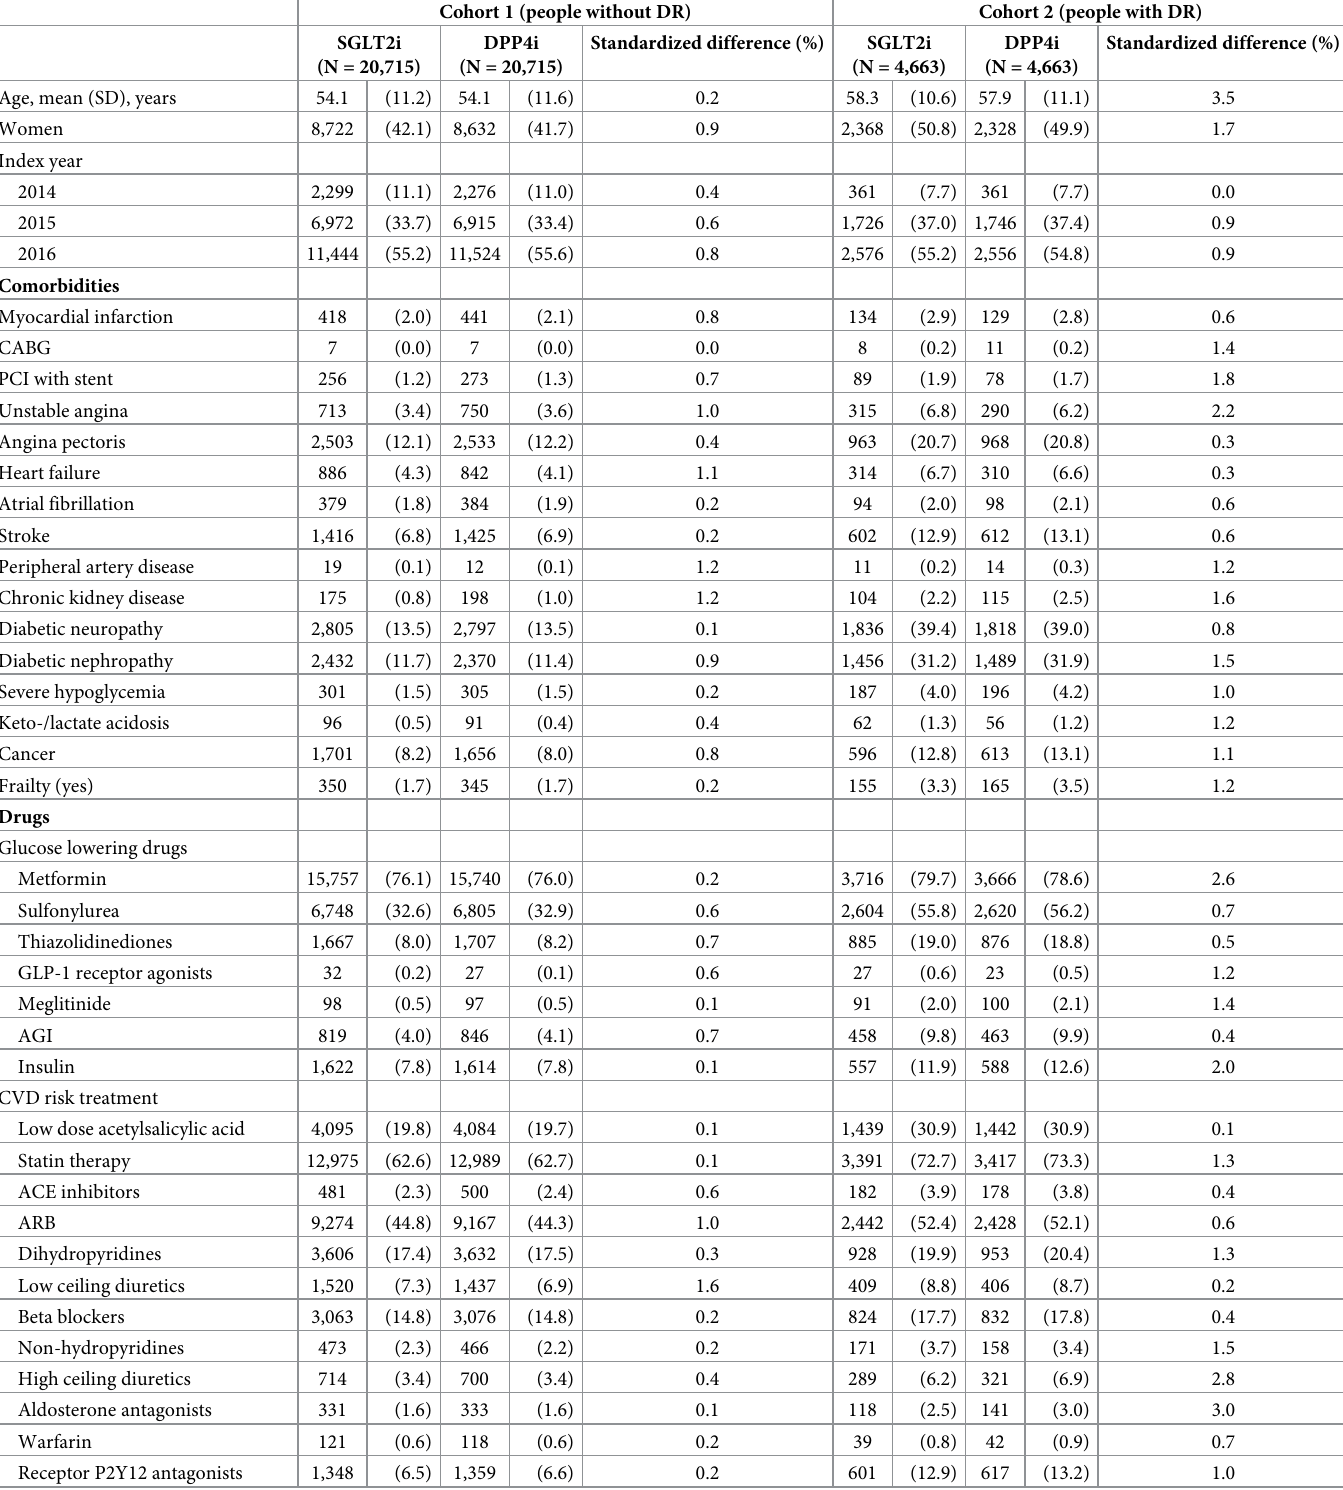
Table 1. Baseline characteristics in propensity score-matched cohorts of SGLT2i and DPP4i